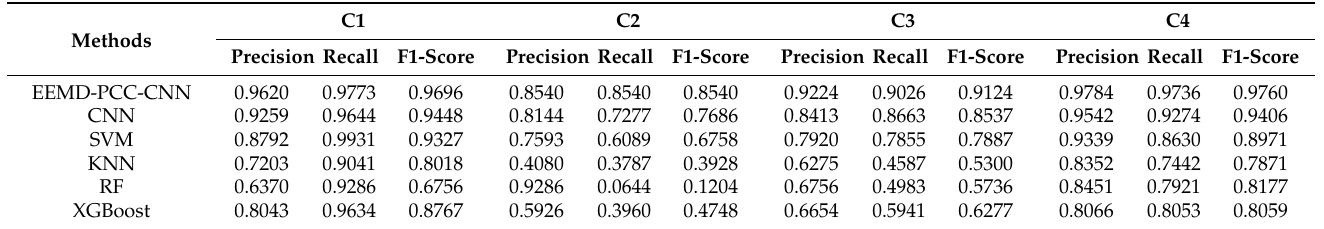
Figure 9. Classification results on the testing dataset for the three-story building structure. Table 6. Classification results of the three-story building structure under four damage conditions.